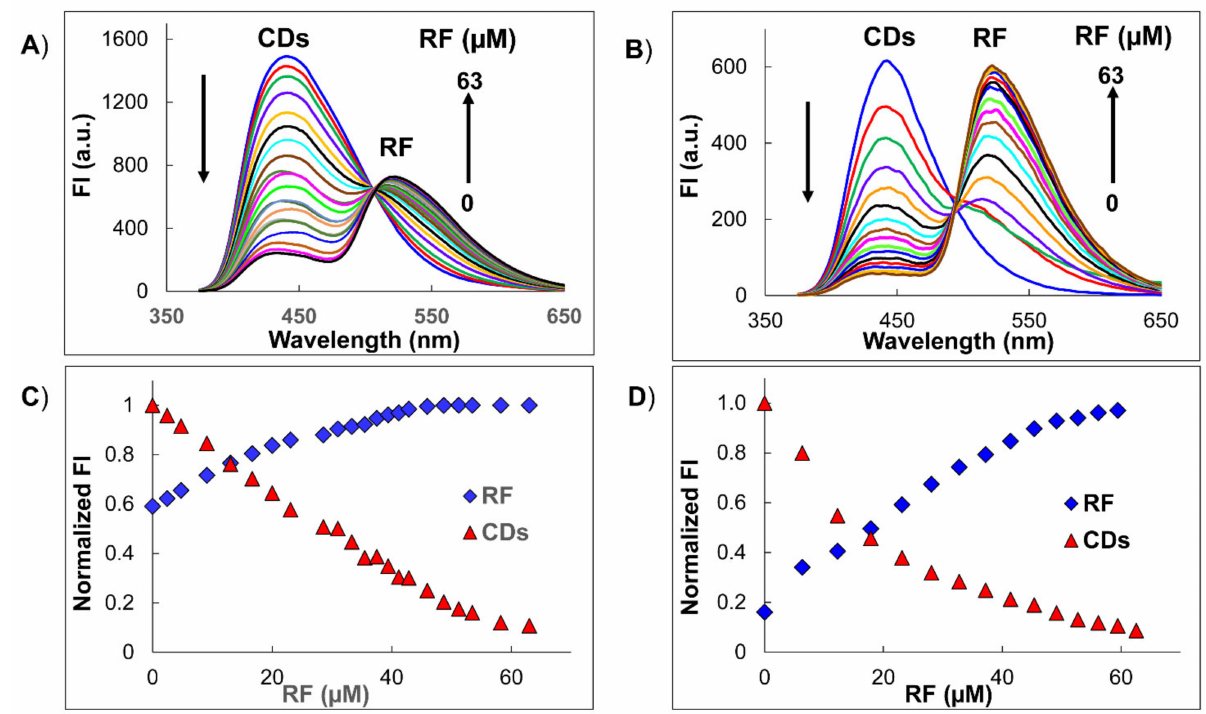
Figure 4. Spectra of the successive titration of CDs with RF at two donor concentrations ( A ) 4.0 × 10 − 2 mg/mL and ( B ) 5.0 × 10 − 3 mg/mL and the normalized fluorescence intensity signal versus RF at two donor concentrations ( C ) 4.0 × 10 − 2 mg/mL and ( D ) 5.0 × 10 − 3 mg/mL. The RF concentrations range from 0 µ M to 63 µ M in all